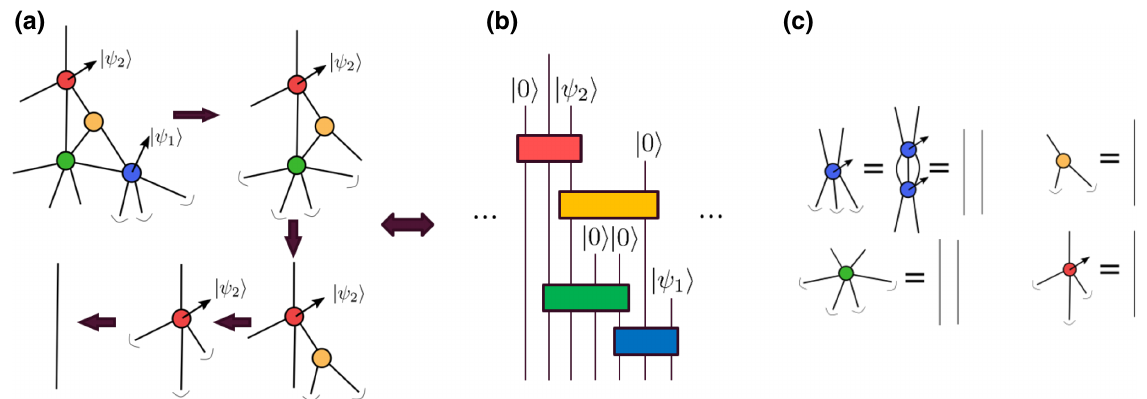
FIG. 3. (a) Contraction sequence for a portion of the tensor network corresponds to (b) a unitary decoding circuit where each unitary gate can be independently derived from the tensor or code of the same color. The arrows denote the encoded logical degrees of freedom [50]. (c) The relevant tensors are isometries in that the contraction of certain edges reduce them to identity operators. A shorthand notation is used to avoid